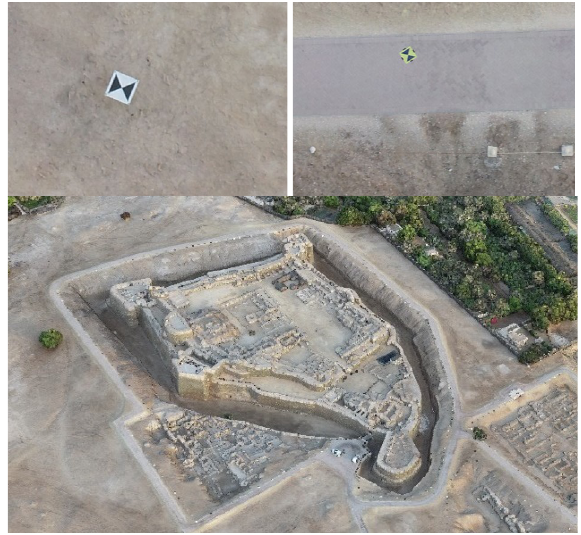
Figure 3. UAV Dense Cloud of Qal'at al-Bahrain, flight altitude 100m. Source: authors and BACA.